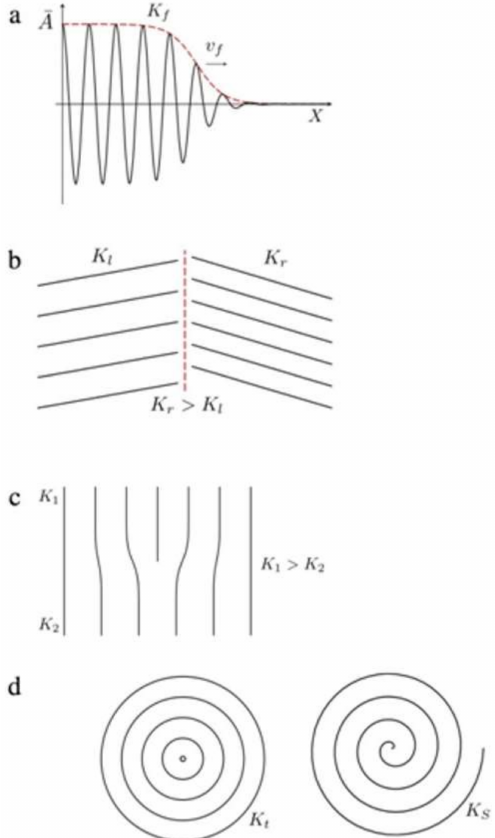
Figure 7. Theoretical domain instability patterns with wavevector K, from Hohenberg and Krekhov [30]. Reprinted from 30. Hohenberg P. C. and Krechkov A. P., An introduction to the Ginzburg–Landau theory of phase transitions and nonequilibrium patterns, Phys. Rpts. 2015, 572, 1–42 (2015)., Copyright (2015), with permission from Elsevier Copyright (2015), with permission from